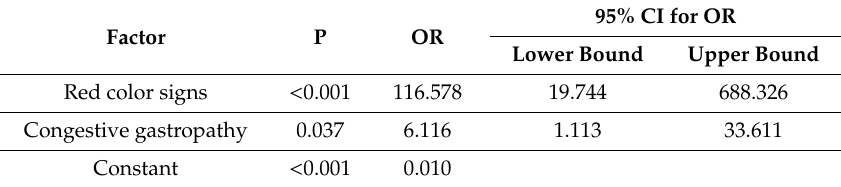
Table 10. Odds ratio values for bleeding risk factors (multivariate logistic regression).